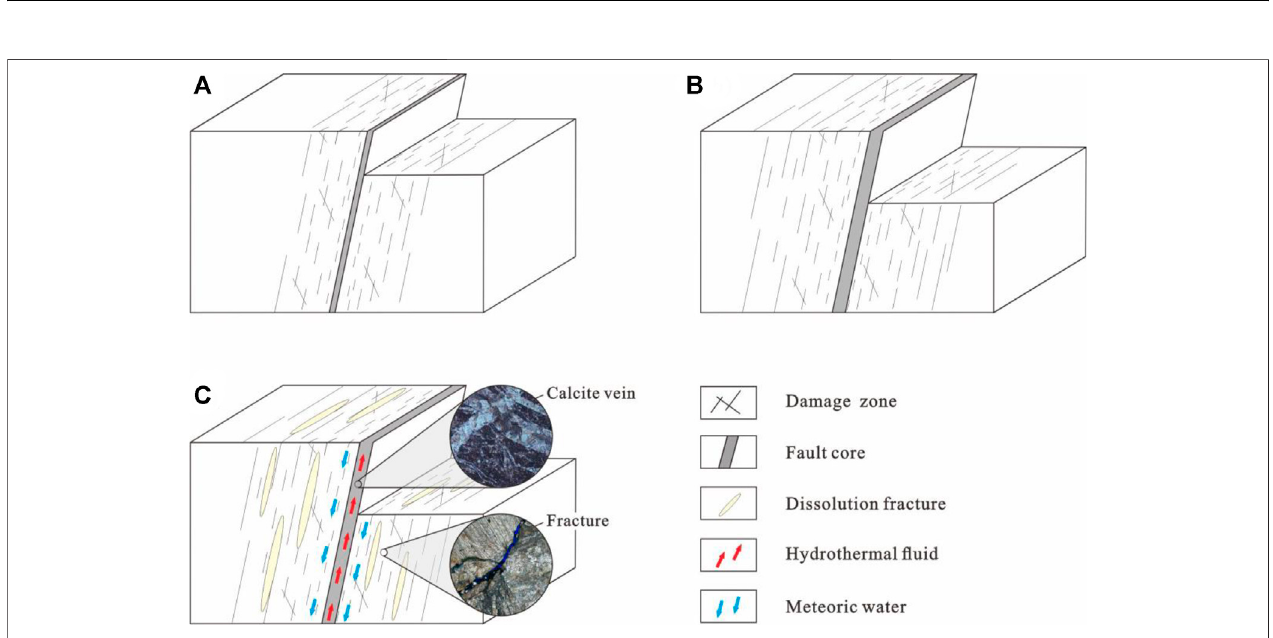
FIGURE8| Distributioncharacteristicsofrareearthelementsindifferentpartsoffaultcore. (A) TheREEcurvesoftheparentrocksamplesshowlittle fl uctuation. (B) The REE curves of the samples in the damage zone are basically consistent with those of the late buried calcite. (C,D) REE curves of fault gouge and slip plane calcite show obvious positive Eu anomaly.